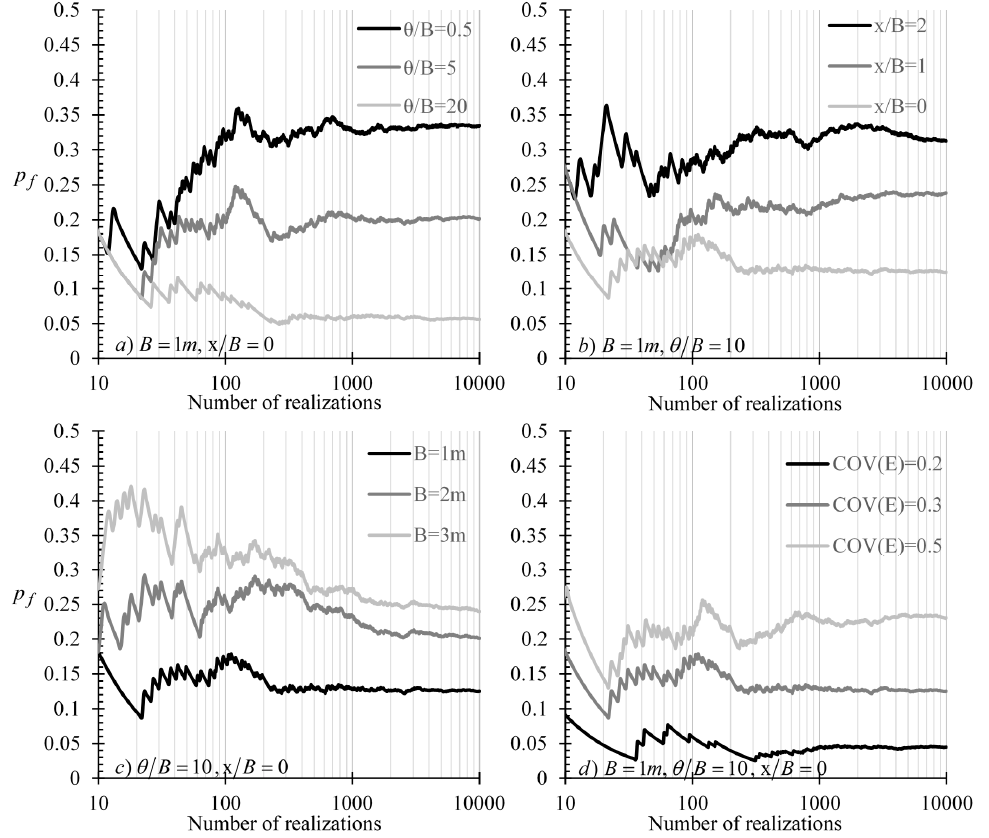
Figure A1. f p versus number of realizations by considering different ( a ) scaled scale of fluctuation values, ( b ) scaled horizontal sampling location values, ( c ) footing widths and ( d ) coefficient of variation of E ; charts referring to d p / B = 0.7 B and x / B = 0.